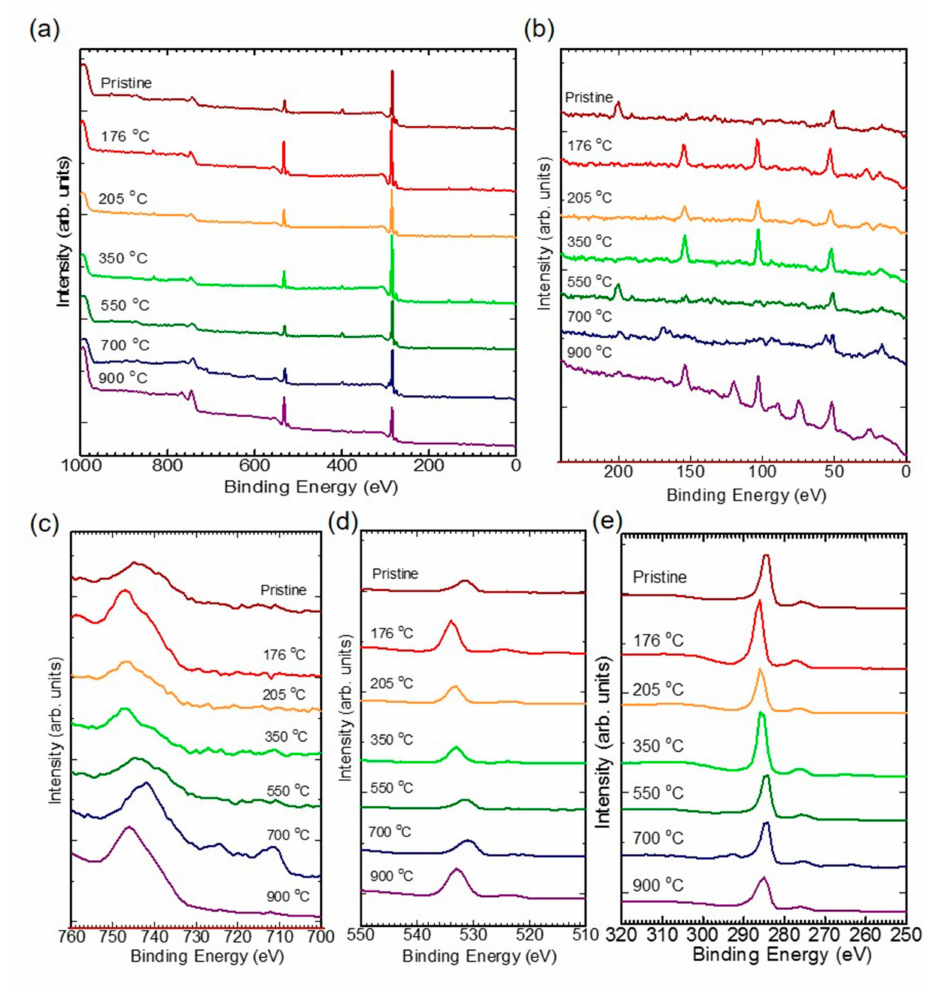
Figure 6. X-ray photoelectron spectroscopy (XPS) results of the B. braunii residue powder carbonized at different temperatures. ( a ) Wide scan results; ( b ) Magnification of low energy region; ( c ) Binding energy shift of Fe 2p1/2 and Fe 2p3/2; ( d ) Binding energy shift of O 1s; ( e ) Binding energy shift of C